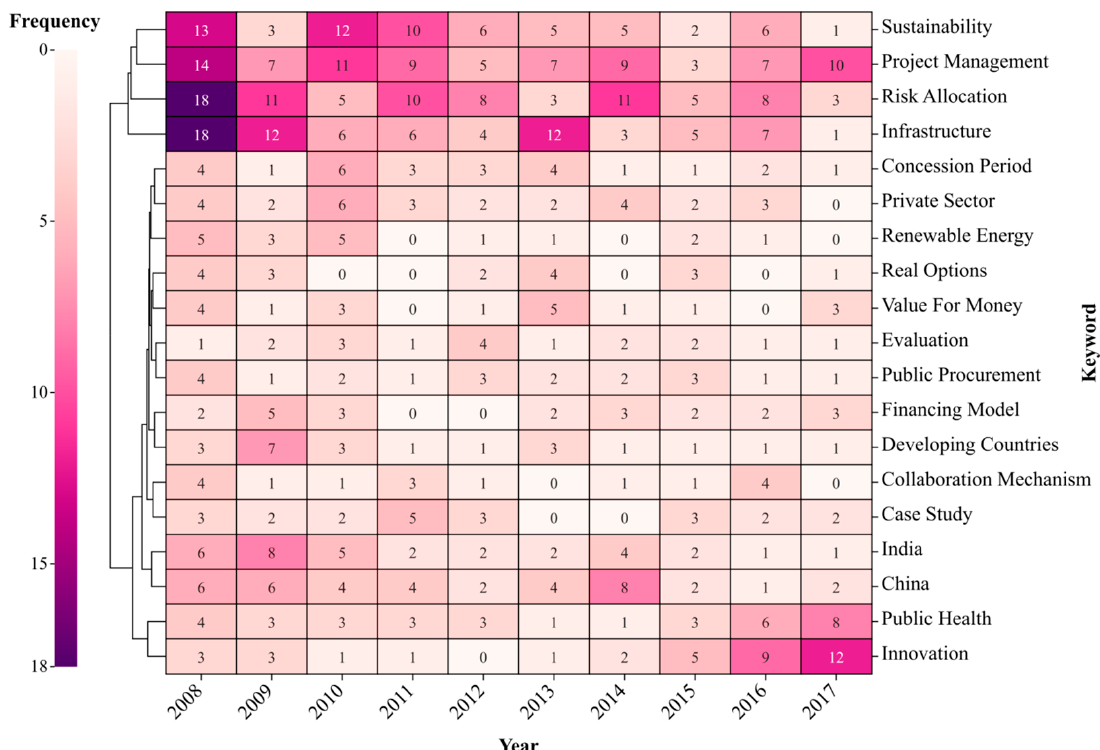
Figure 5. Time Zone Biclustering Analysis in Exploration Period.